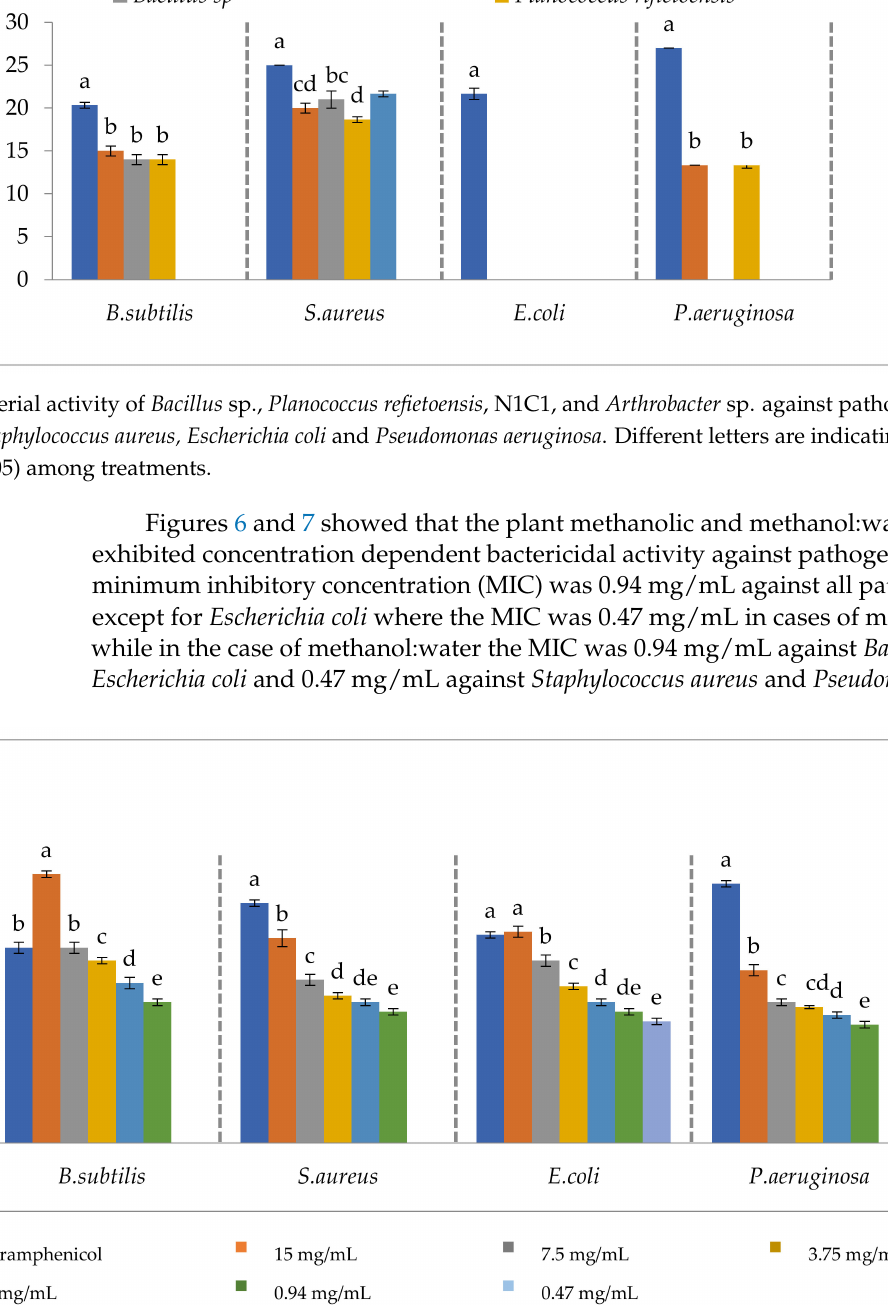
Figure 6. Antibacterial activity of methanolic extracts of aerial parts of Aerva javanica against pathogenic strains Bacillus subtilis , Staphylococcus aureus , Escherichia coli , and Pseudomonas aeruginosa at different concentrations. Different letters are indicating significant differences ( p < 0.05) among